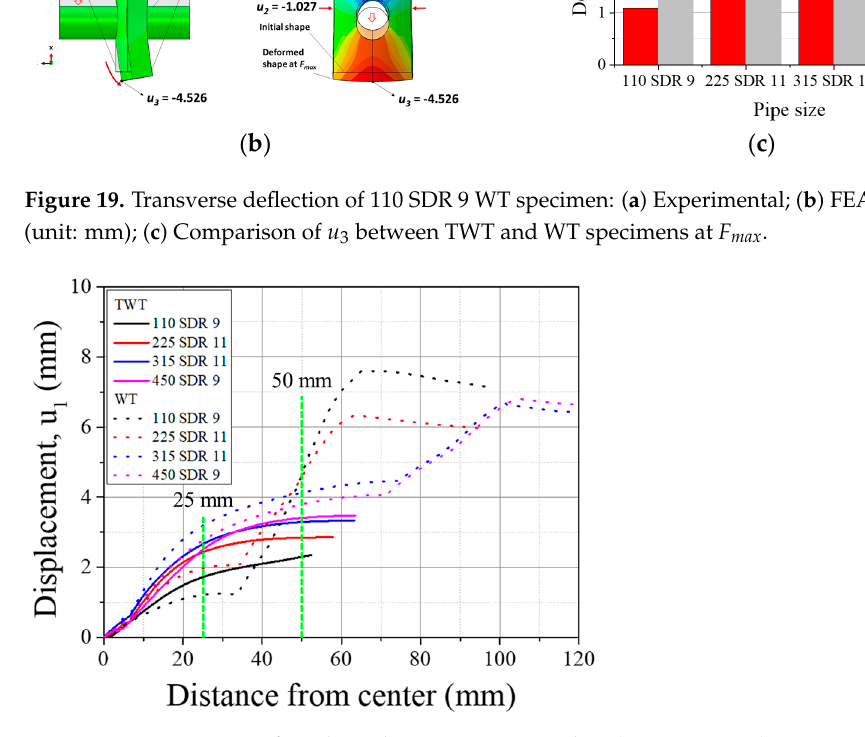
Figure 20. Comparison of u 1 along the specimen centerline (see Figure 12c).